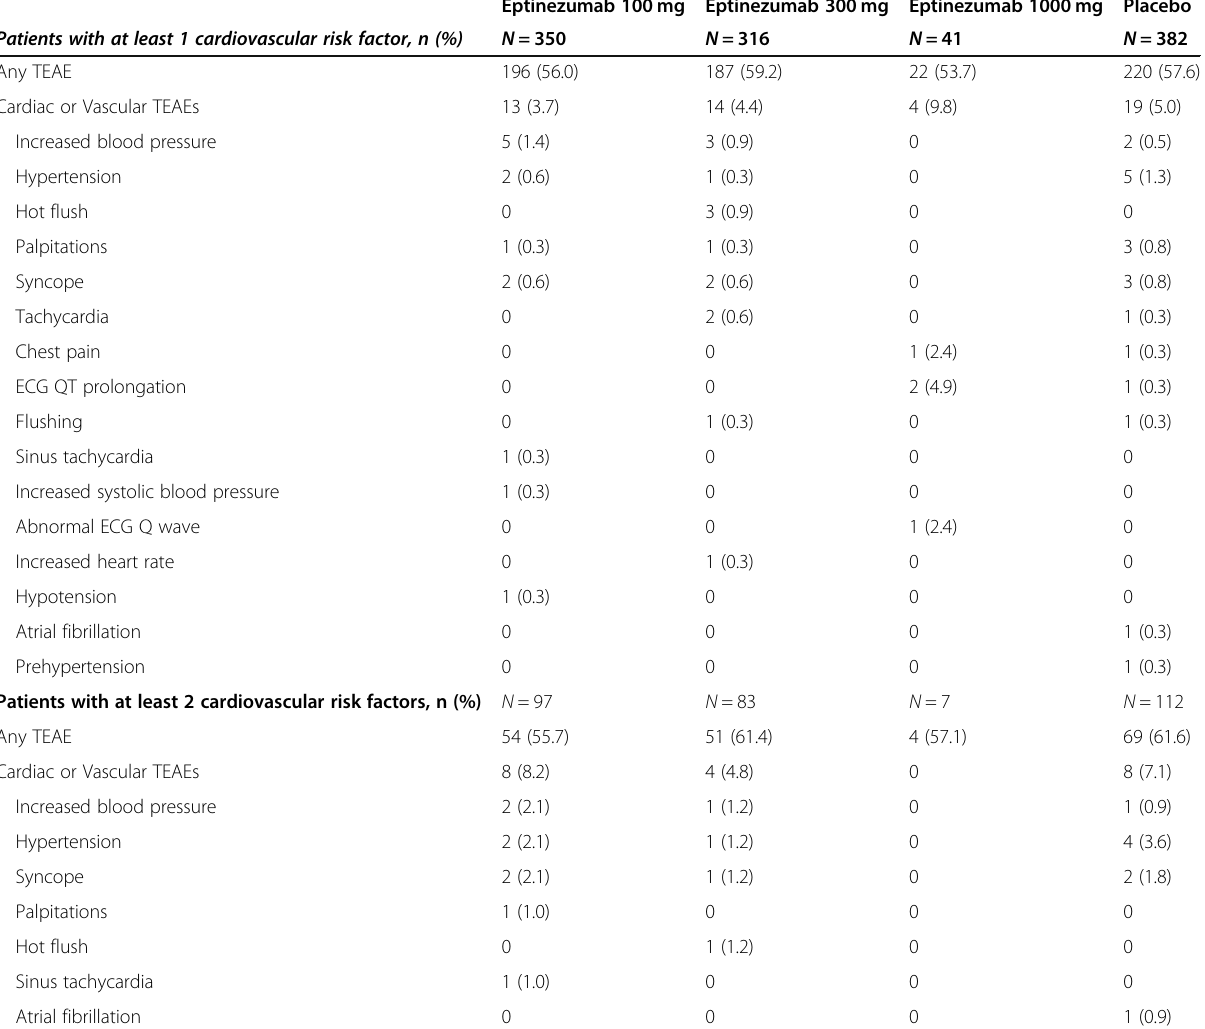
Table 5 Treatment-Emergent Cardiovascular Adverse Events in Patients with Cardiovascular Risk Factors at